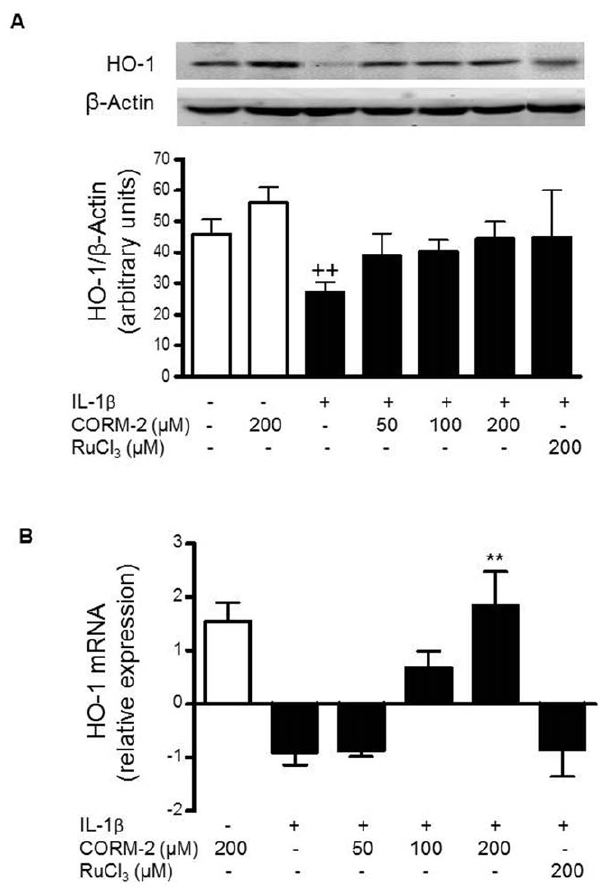
Figure 1. Effect of CORM-2 on HO-1 protein (A) and mRNA expression (B) in OA synoviocytes. Cells were stimulated with IL-1 b (10 ng/ml) for 24 h (A) and 16 h (B) in the presence or absence of CORM-2 (50, 100, 200 m M) or RuCl 3 (200 m M). Protein expression was determined in cell lysates by Western blotting and mRNA levels were determined by real-time PCR. Relative expression of HO-1 and b -actin protein bands was calculated after densitometric analysis. Data are expressed as mean 6 S.E.M. Samples from 4 patients were used. ++ P , 0.01 with respect to nonstimulated cells. ** P , 0.01 with respect to IL-1 b .